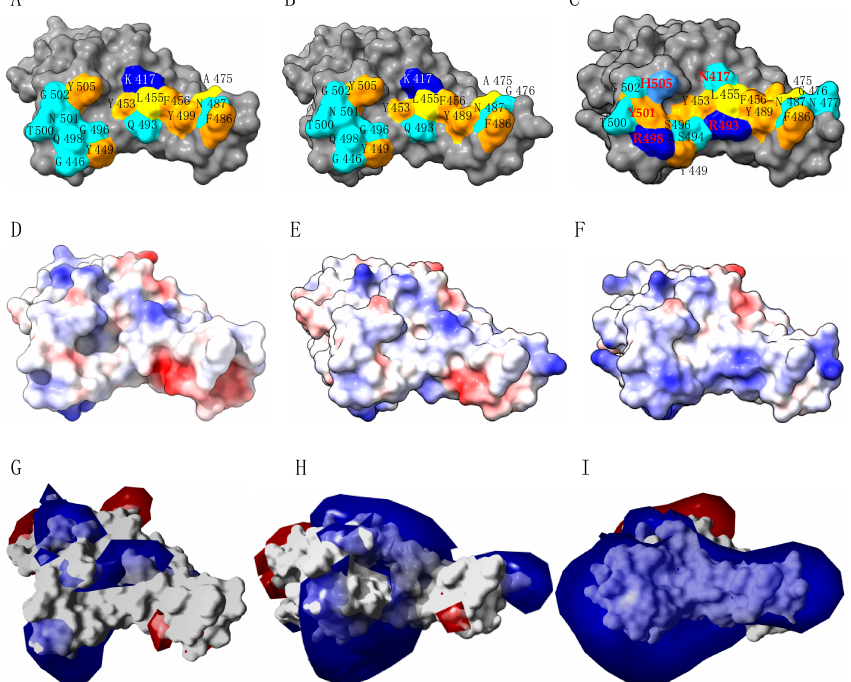
Figure 7. ( A – C ). Mapping of amino acid residues on the molecular surface of RBD (colored grey) of the SARS-CoV-2 Wuhan wt ( A ), delta variant ( B ) and omicron variants ( C ), which directly interact with the corresponding surface of ACE2. Amino acid residues are labelled in black and red for the mutated residues of the SARS-Co2 omicron variant. ( D – F ). Mapping of calculated Coulombic charges on the molecular surface of RBDs from the SARS-CoV-2 Wuhan wt ( D ), delta variant ( E ) and omicron variant ( F ). Electropositive and electronegative surfaces are colored blue and red, respectively. Neutral surfaces are white. ( G – I ) Calculated surface electrostatic potentials at the surface of RBD from the SARS-CoV-2 Wuhan wt ( G ), delta variant ( H ) and omicron variant ( I ). Electropositive and electronegative potentials are colored blue and red, respectively.